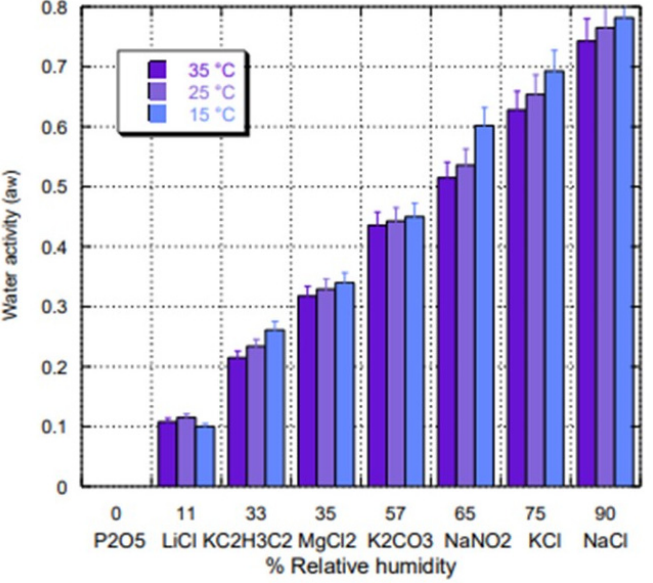
Figure 11. a w of edible film of cassava starch.